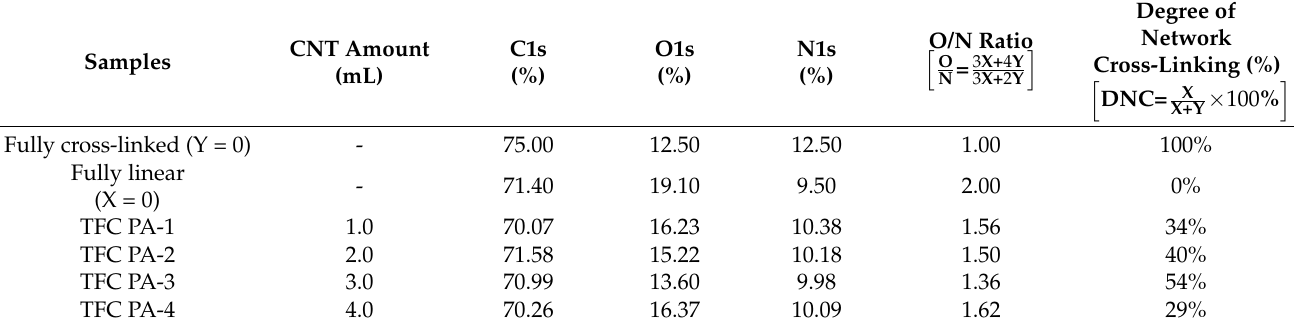
Table 3. Elemental compositions of PA layers from TFC-PA membranes (the degree of cross-linking of PA active layer was calculated from the ratio of network to linear cross-linked portion of the